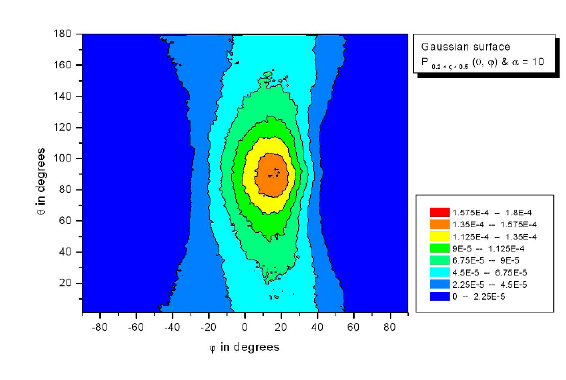
Figure 5. Simulation results for the normalized PDFs, ( θ , 0.2 < ζ < 0.5 P ( θ , ϕ ), at relatively high Peclet number 0.2 < ζ < 0.5 ( α = 100), in the depletion layer near a Gaussian rough solid surface